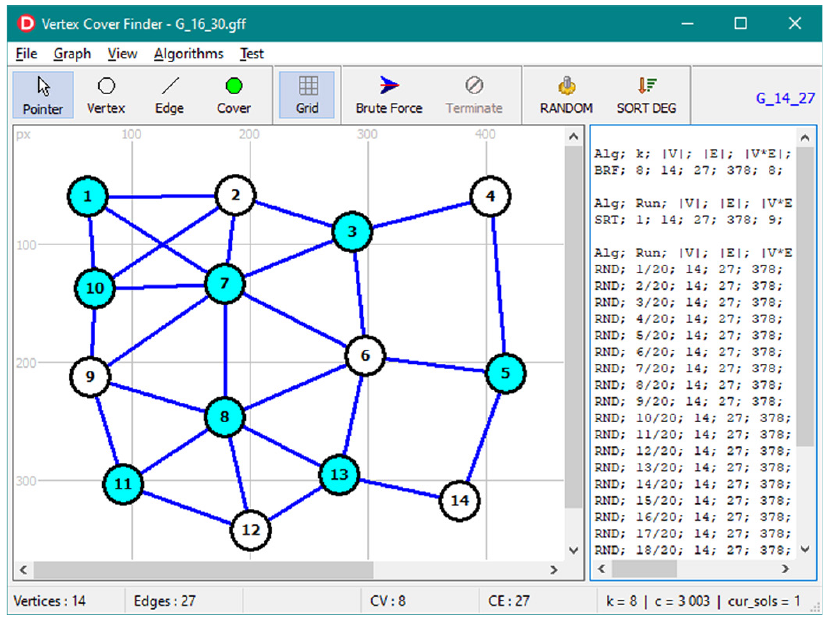
Fig. 5. A working session with the VertexCoverFinder applicaton